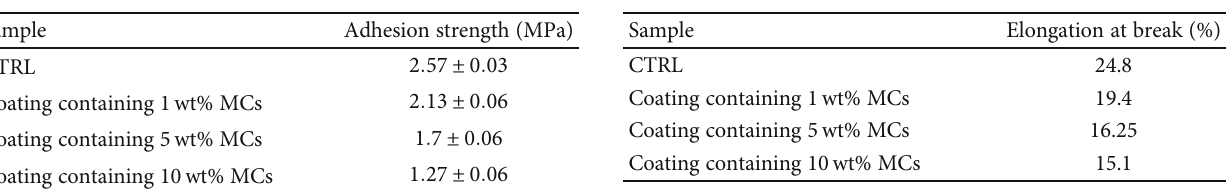
Table 4: Elongation at break (%) of the prepared